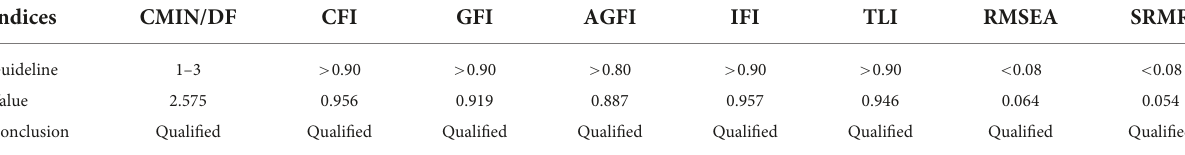
TABLE 5 The structural model fit